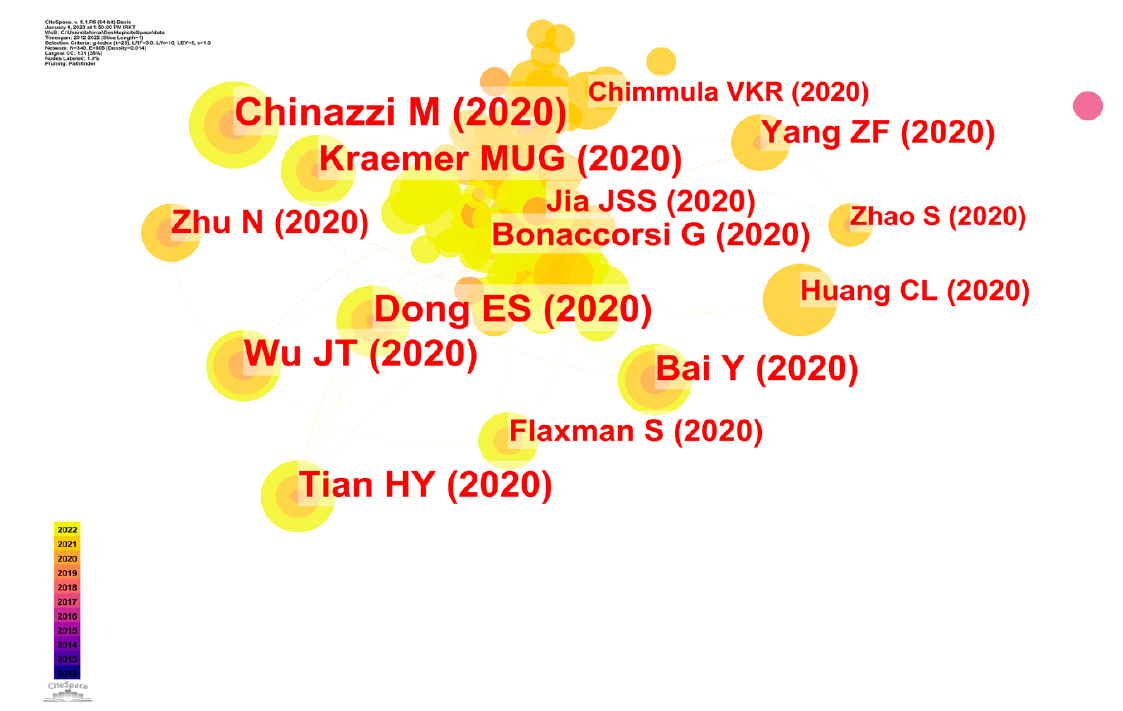
Figure 8. CS map of document co-citation analysis of studies of epidemic control based on big data research.